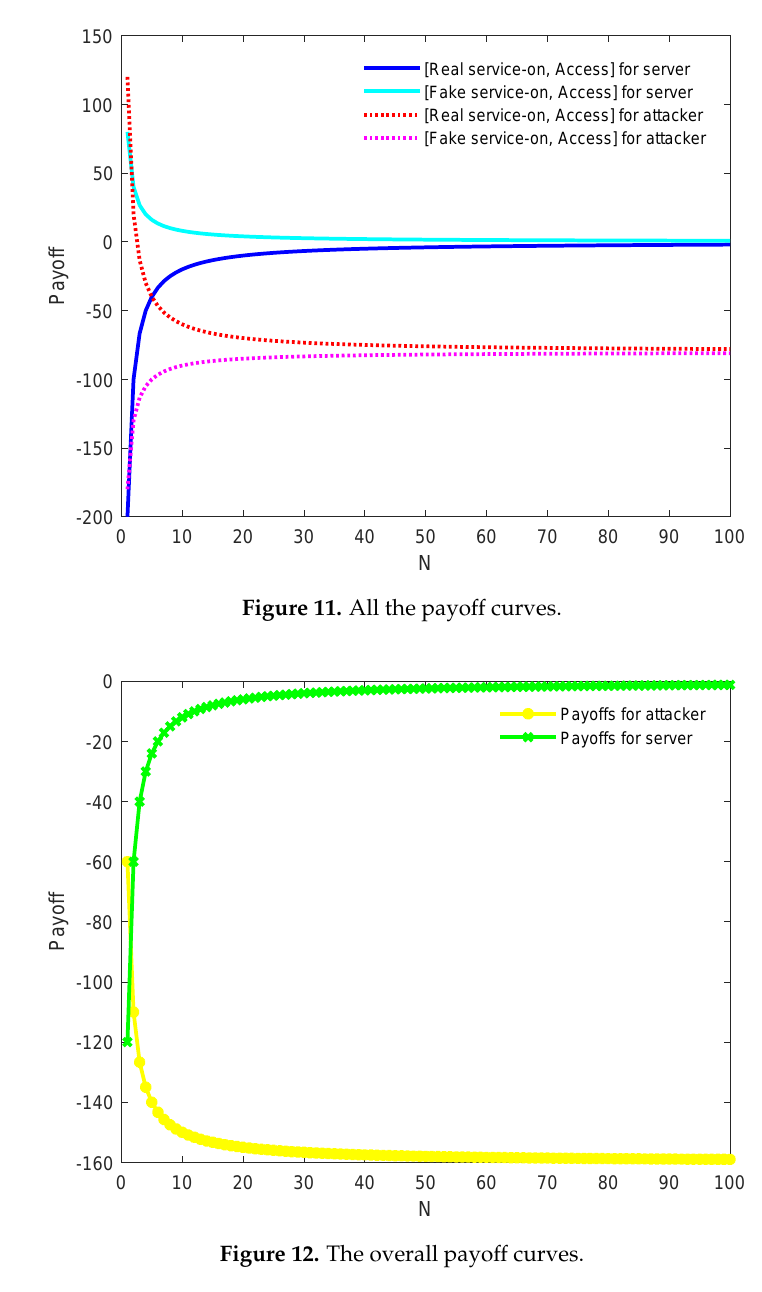
Figure 12. The overall payoff